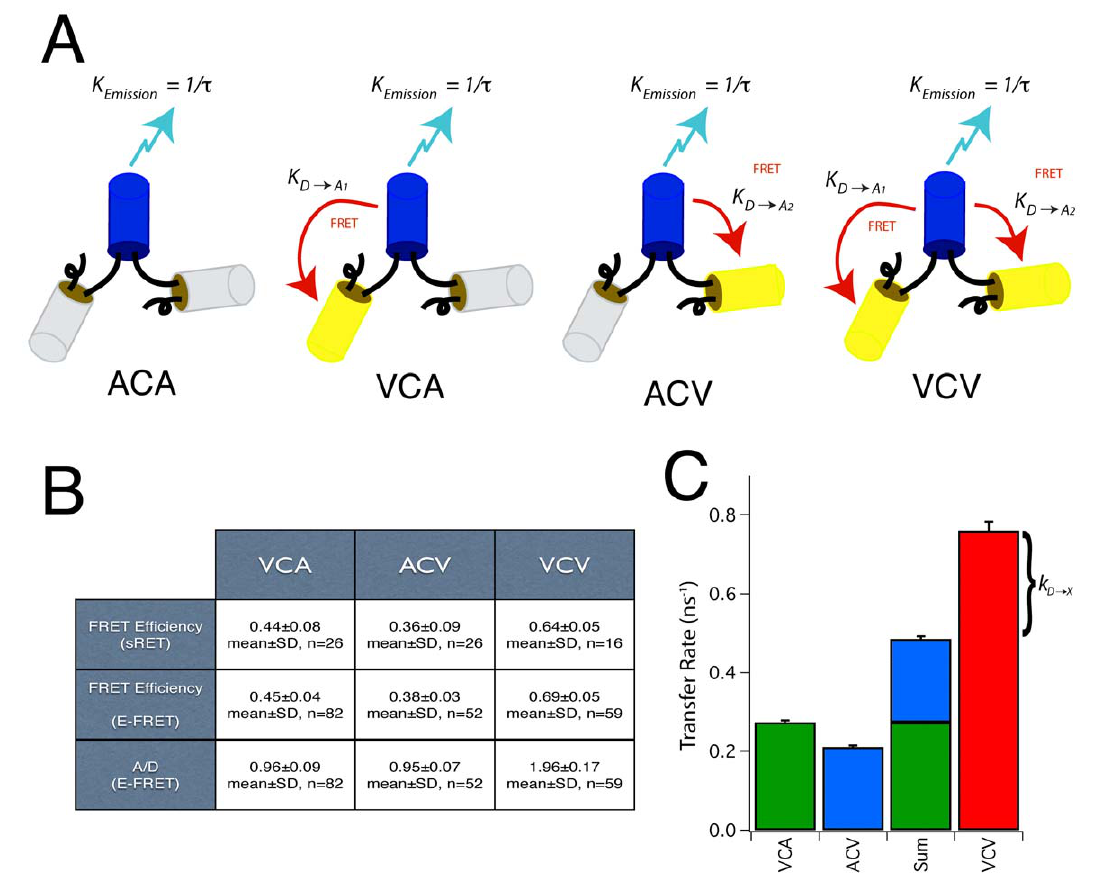
Figure 2. Predicting the FRET efficiency of a construct with two acceptors. A. Constructs used to study the effects of having two acceptors in a FRET complex. Blue ‘‘cans’’ depict the Cerulean donor, Yellow depicts Venus acceptors, and gray depicts Amber, which has a single point mutation in Venus that prevents it from forming a fluorophore. Arrows leading away from Cerulean represent both radiative and non-radiative emission pathways. Blue arrows show radiative emission when Cerulean emits a photon. Red arrows depict non-radiative pathways for releasing excitation energy involving FRET. B. Table comparing the FRET efficiencies of VCA, ACV, and VCV measured by either sRET or E-FRET, as well as the measured acceptor to donor ratio (A/D) for each construct. C. Energy transfer rates and their propagated error were calculated from the measured Cerulean lifetime of ACA and the FRET efficiencies measured by E-FRET of individual constructs. The Sum column is the arithmetic sum of the VCA and ACV transfer rates with propagated error and by theory should equal the transfer rate measured for VCV.